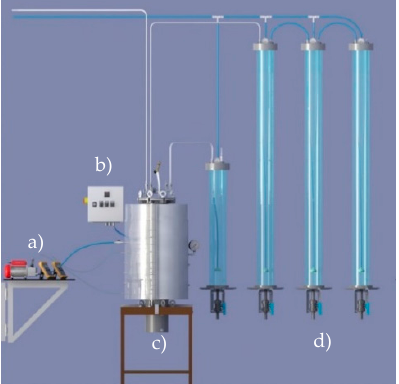
Figure 3. Gasification experimental apparatus: ( a ) vacuum pump, ( b ) control panel, ( c ) reactor, and ( d ) wet scrubber.